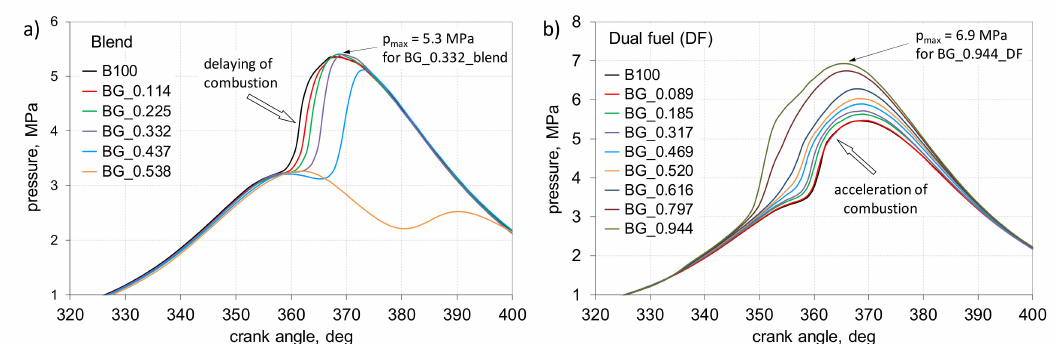
Figure 4. Pressure courses for blends ( a ) and dual fuel ( b ) combustion